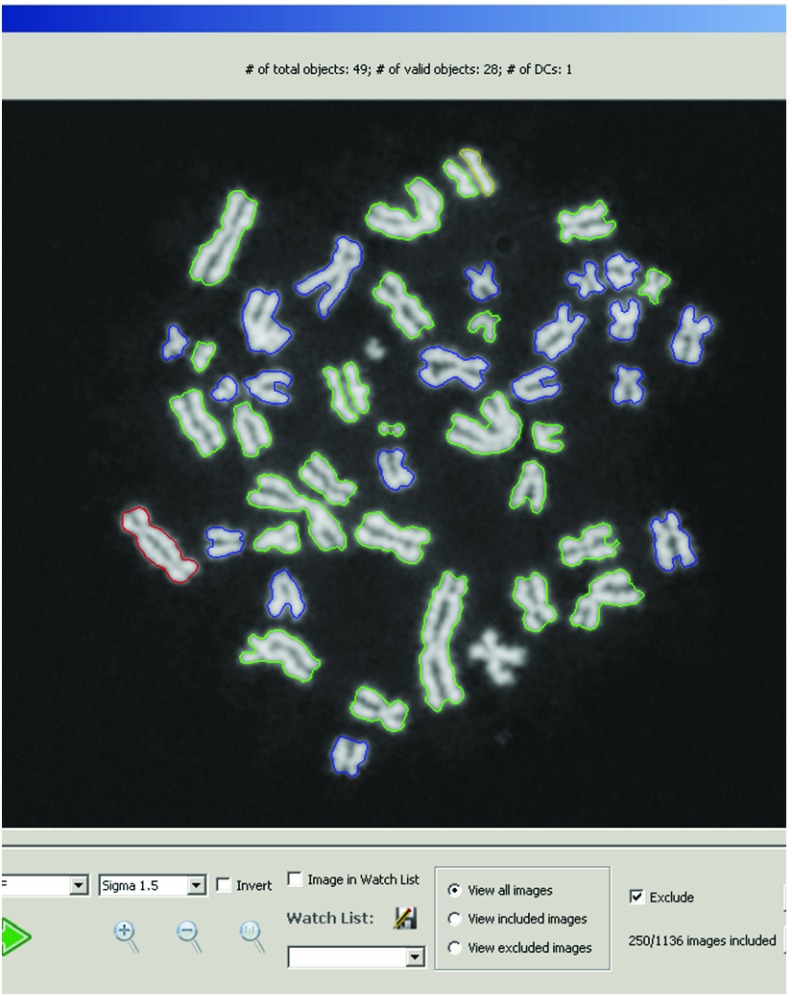
Cell image viewer in ADCI demonstrating example of a corrected false positive (FP) DC.Graphical User Interface for viewing cell images within a sample processed by ADCI
11. Valid segmented objects (generally chromosomes, but occasionally nuclei or debris) are shown with coloured contours. Red contours indicate predicted DCs, yellow contours indicate chromosomes that were initially classified as DC and then reclassified by the FP filters (example at 12 o’clock), green contours indicate predicted MCs, and blue contours indicate objects that could not be further processed after image segmentation. Below the cell image, options were added to allow manual inclusion or exclusion of images within a sample from dose determination.